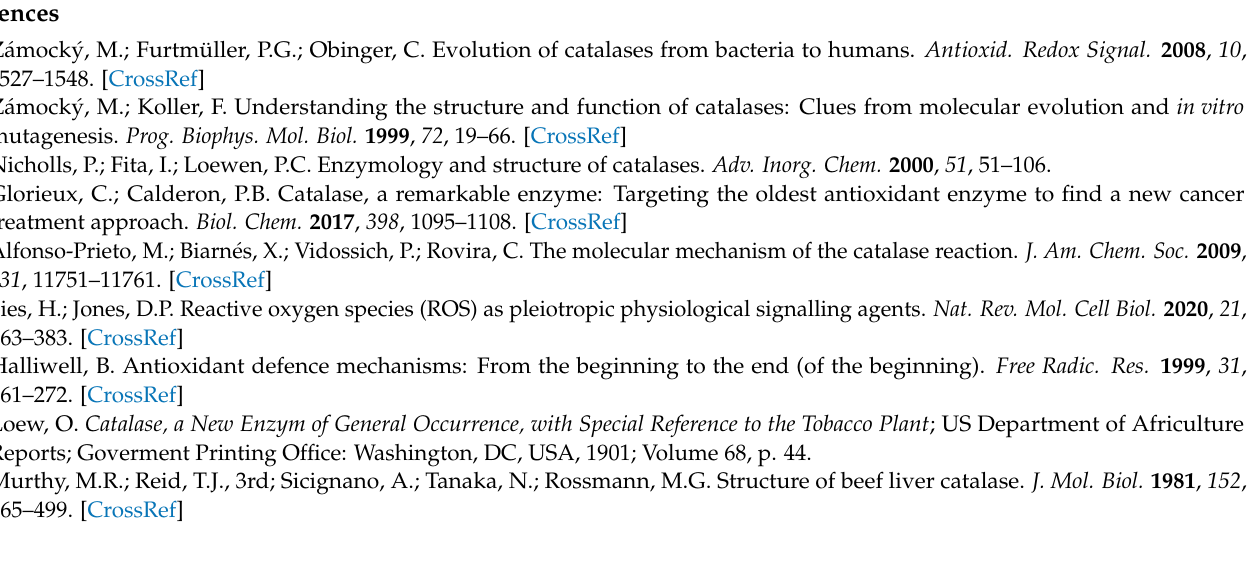
Figure S3: Kinetic analysis of catalase activity in the presence of inhibitors; Figure S4: Kinetic analysis of catalase activity at different pH; Figure S5: PAE plots for structures of catalases predicted in this study; Table S1: Source of genomic data used for catalase copy number analysis; Table S2: Sequences of primers used in this work; Table S3: Pairwise sequence identity values for 13 trypanosomatid cata- lases; Table S4: RMSD values for the three trypanosomatid catalases and their closest PDB relatives. Data are presented in